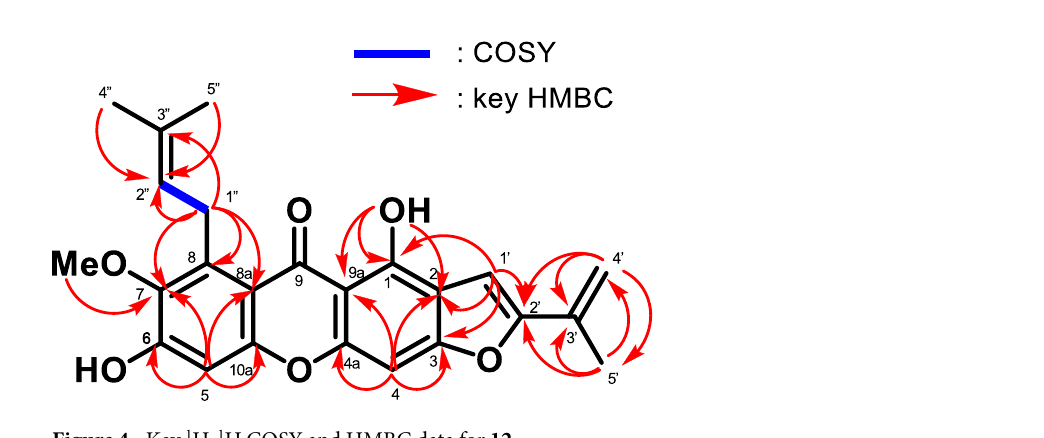
Figure 4. Key 1 H- 1 H COSY and HMBC data for 12